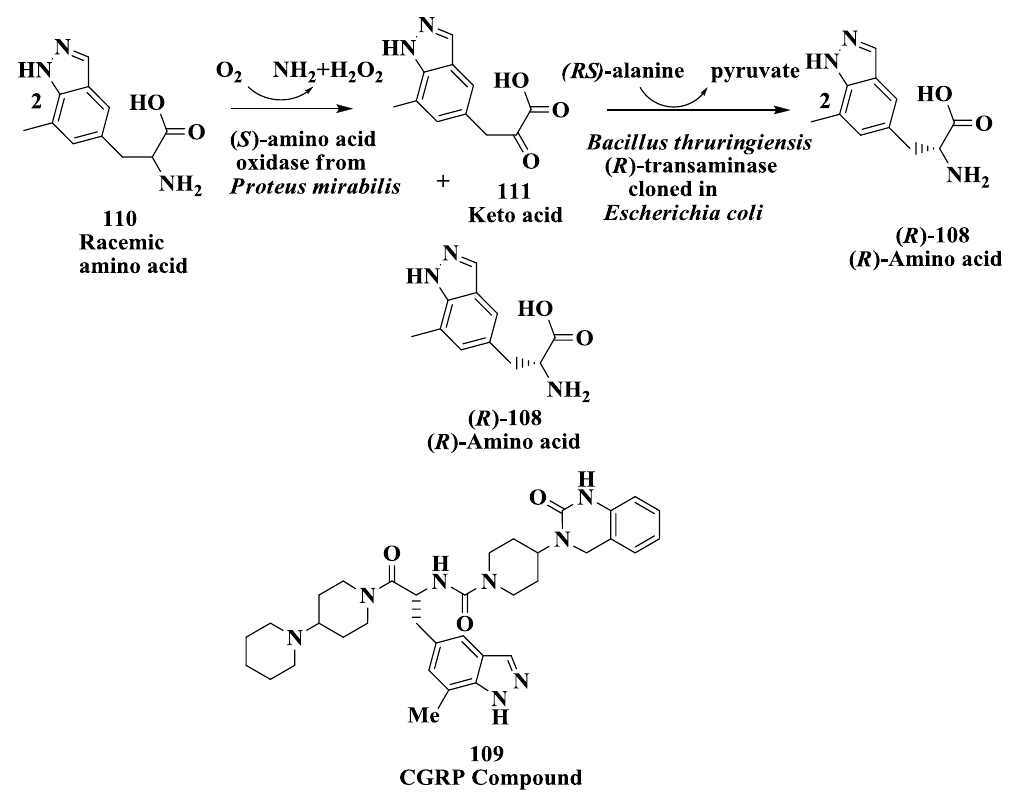
Figure 30. Calcitonin gene-related peptide receptors (antimigraine drugs):